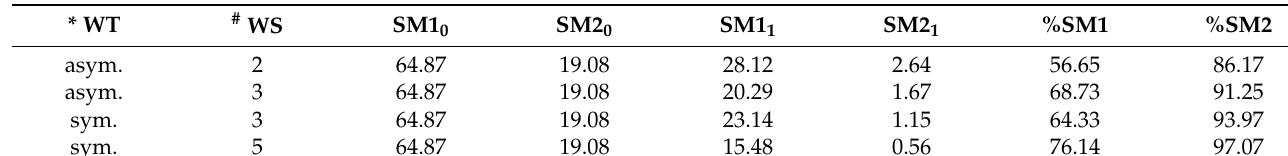
Table 1. Performance metrics of the moving average filtering method for different window types and sizes. The definitions of the symbols used are provided in the corresponding explanations for Equations (9)–(11). * WT: window type; # WS: window size.